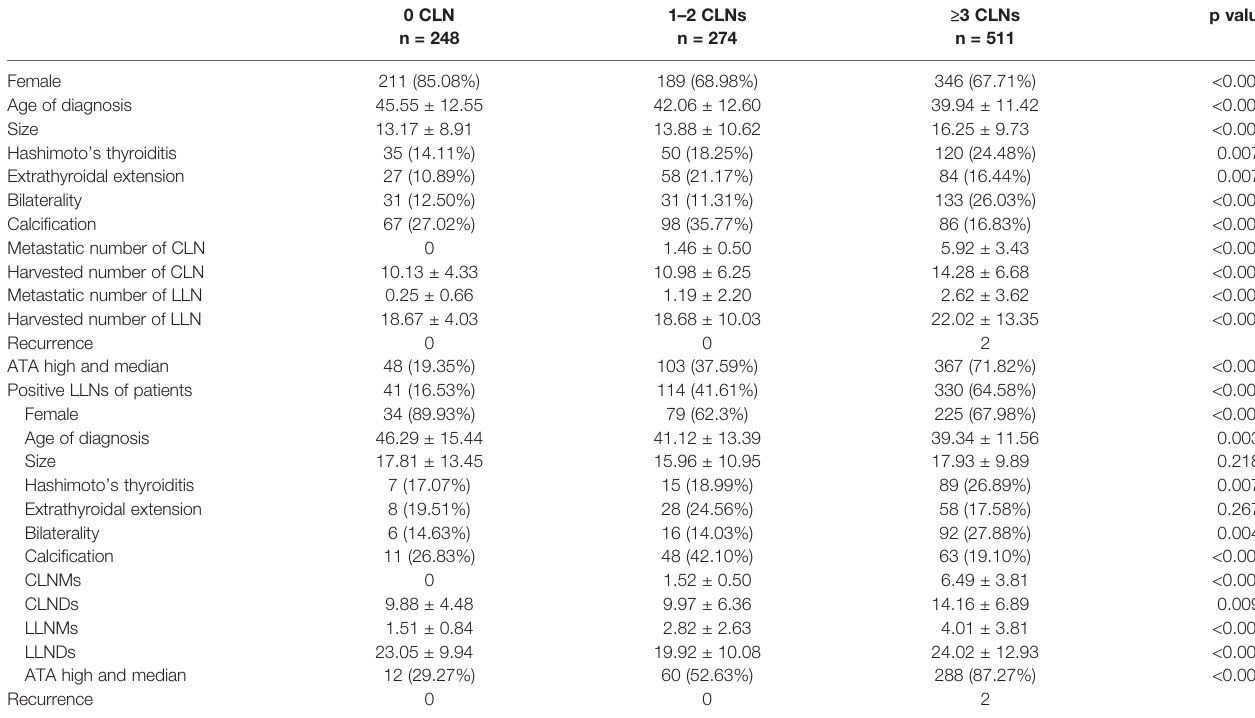
TABLE 1 | Demographic pro fi le and comparisons of clinicopathological factors of the cohort based on the number of CLN-positive cN0 PTC patients. 0 CLN 1 – 2